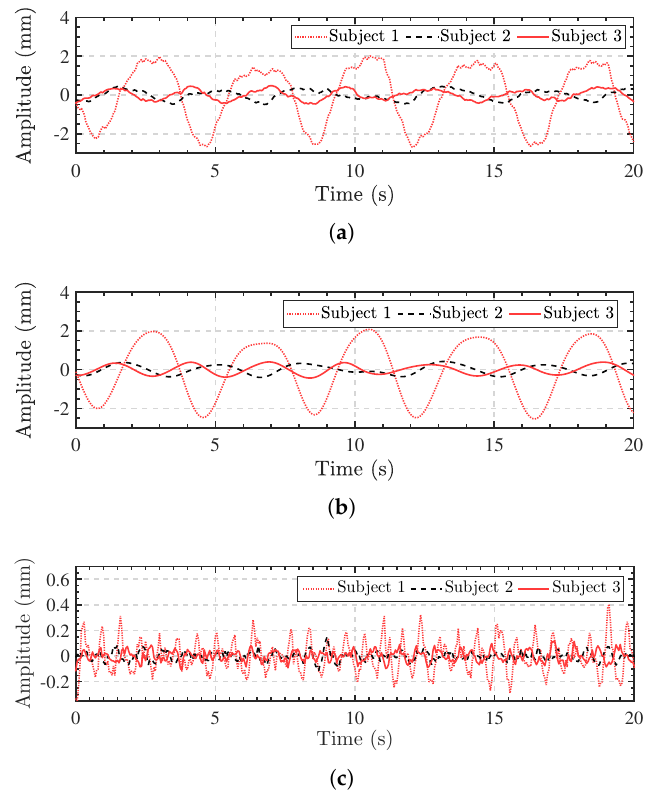
Figure 13. Through-wall vital signs detection results of multiple subjects. ( a ) The extracted vi- tal signs signals of the three subjects. ( b ) The separated respiration patterns. ( c ) The separated heartbeat